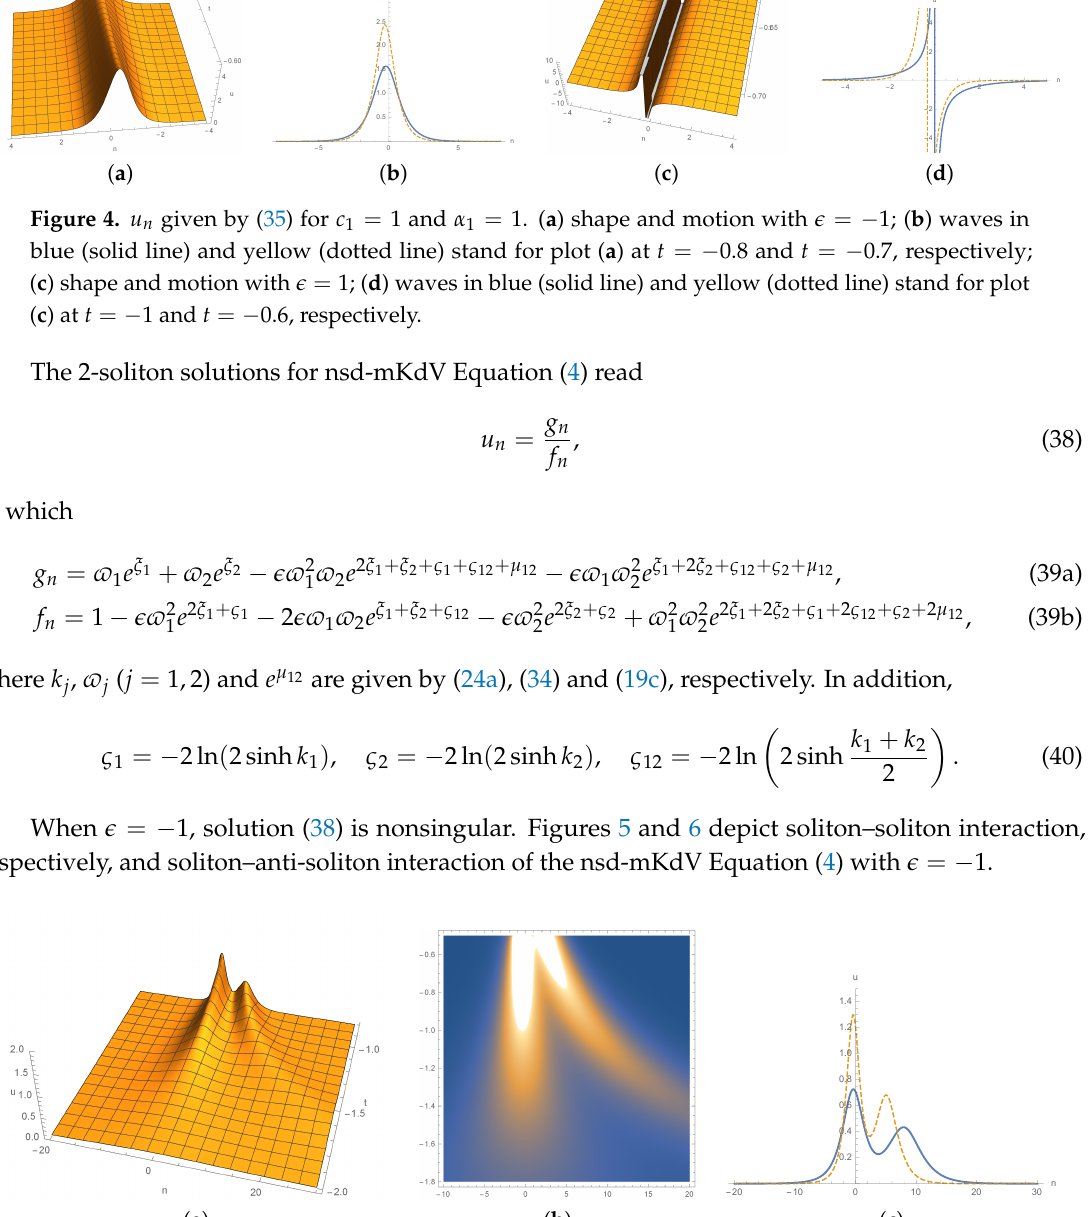
Figure 4a,c depict the solution (35) with (cid:101) = − 1 and (cid:101) = 1, respectively. Figure 4b shows the symmetric shape and the Gaussian-distributed structure with respect to n for a given t . Figure 4d exhibits the movement of the singularity point.